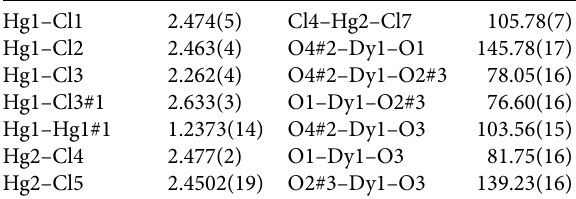
Table 2. Some bond lengths (Å) and angles